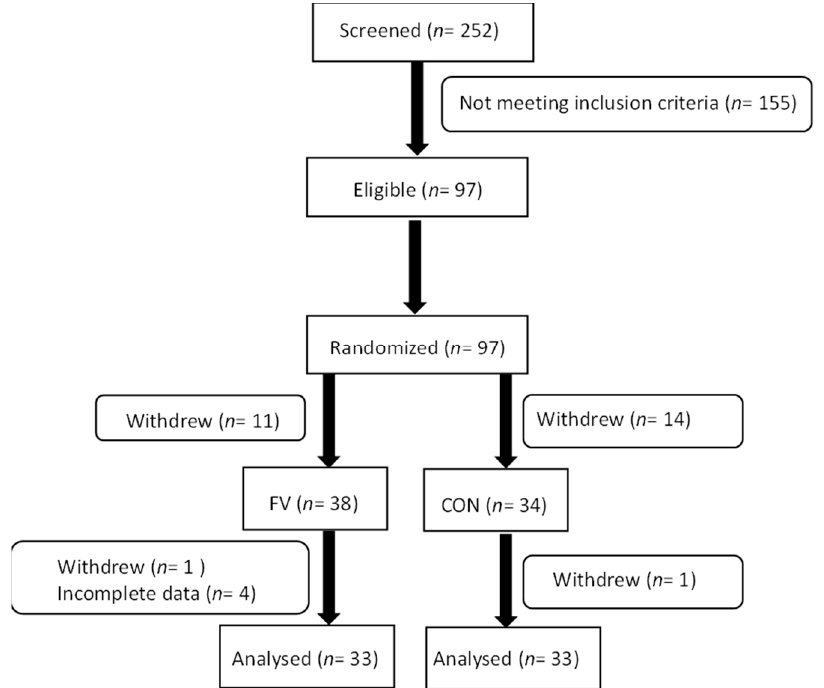
Figure 1. Trial flowchart showing enrolment, allocation, and analysis of participants in the RCT. FV: fruit and vegetable, CON: control.